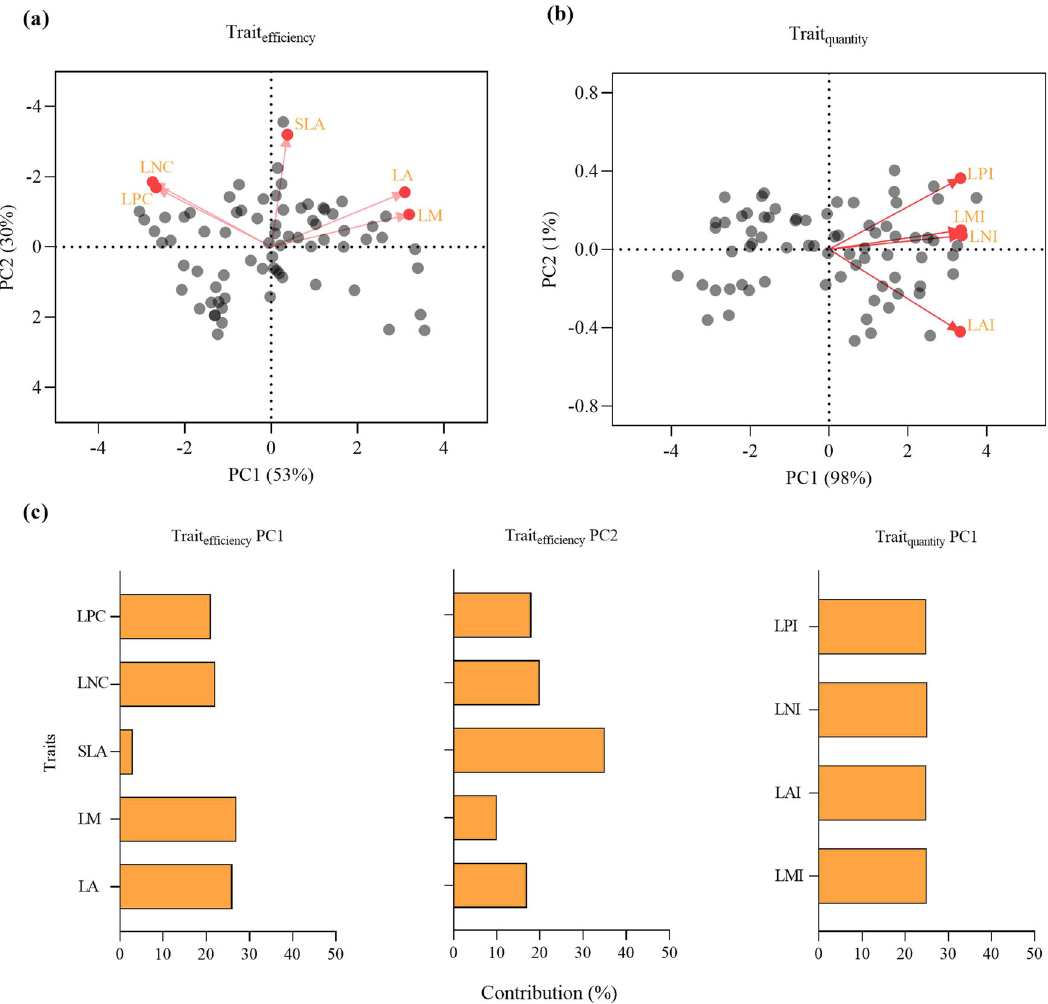
Fig. 6 Dimensions for multiple traits. a and b Biplots resulting from the principal component analysis for ef fi ciency trait (Trait ef fi ciency , a ) and capacity trait (Trait quantity , b ). Grey points: different sites. c Bar plots of the contributions; LA, leaf area (cm 2 ); LM, leaf dry mass (g); SLA, speci fi c leaf area (cm 2 /g); LNC, leaf nitrogen concentration (mg/g); LPC, leaf phosphorus concentration (mg/g); LAI, leaf area index (m 2 /m 2 ); LMI, leaf mass index (g/m 2 ); LNI, total leaf nitrogen per unit land area (g/m 2 ); and LPI, total leaf phosphorus per unit land area (g/m 2 for shrubland, and 1m × 1m for grassland) to investigate the community structure during the plant growth peak period from July to August (see Text S3 for more information on the sampling protocol). In each plot within a site, key plant community structure variables were measured, including species identity, species number, plant height, diameter at breast height (DBH; basal stem diameter for shrubs) for all woody plants with DBH ≥ 1 cm, and aboveground biomass for herbaceous species. The measured individual-level functional traits for woody and herbaceous plants included leaf area (LA, cm 2 ), leaf dry mass (LM, g), speci fi c leaf area (SLA, cm 2 /g), leaf nitrogen concentration (LNC, mg/g), and leaf phosphorus concentration (LPC, mg/g), closely related to plant photosynthesis and growth 29,49 (Text S4). Functional traits were divided into size traits, re fl ecting plant size and light competitiveness, and economic traits, re fl ecting leaf photosynthetic capacity and nutrient economic 40,50 . All of these traits selected in this study are closely related to the plant light competitiveness and ecosystem photosynthetic capacity. Soil samples from the 0 – 10cm soil layer were collected via auger boring for ana- lysis of total soil carbon (%), nitrogen (%), phosphorus (%), and soil pH (Text S5). For further details regarding plot setting, plant trait measurement, and soil analysis, see Text S2 – 4, and other sources published by this team 51 – 53 . Climate and length of the growing season . Monthly mean temperature (MMT) and precipitation (MMP) data were downloaded from Climatologies at High resolution for the Earth ’ s Land Surface Areas (CHELSA, https://chelsa-climate.org/ ) 54,55 . Monthly potential evapotranspiration data were downloaded from the Site-speci fi c annual GPP data for 2000 – 2016 were extracted from a global GPP raster dataset with a moderate spatial resolution (500m), validated against 113 Global Potential Evapo-Transpiration Climate Database (http://www.csi.cgiar.org). eddy covariance fl ux towers across the globe 58 . We also calculated monthly GPP The moisture index (MI) was calculated as MMP/PET to represent the monthly water balance of the sample sites 56 . All consecutive months meeting the following (GPP monthly = GPP yearly /GSL).